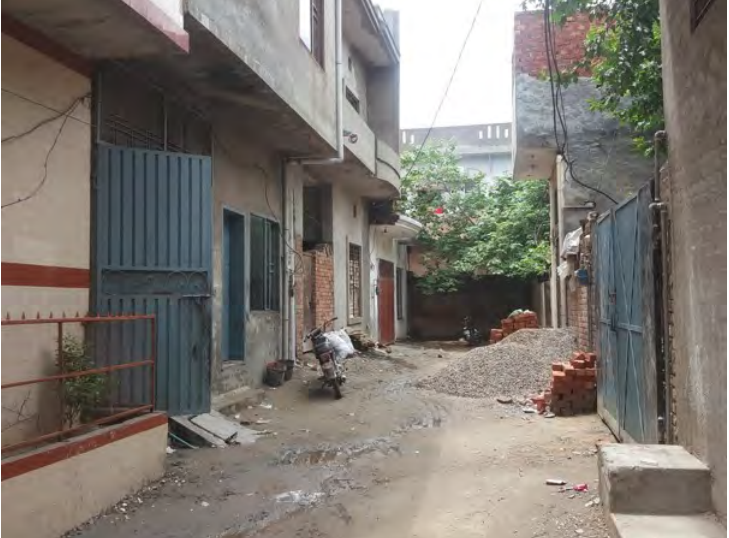
Figure 6. Recent Incremental House construction in Qalandar Pura, Source: Author